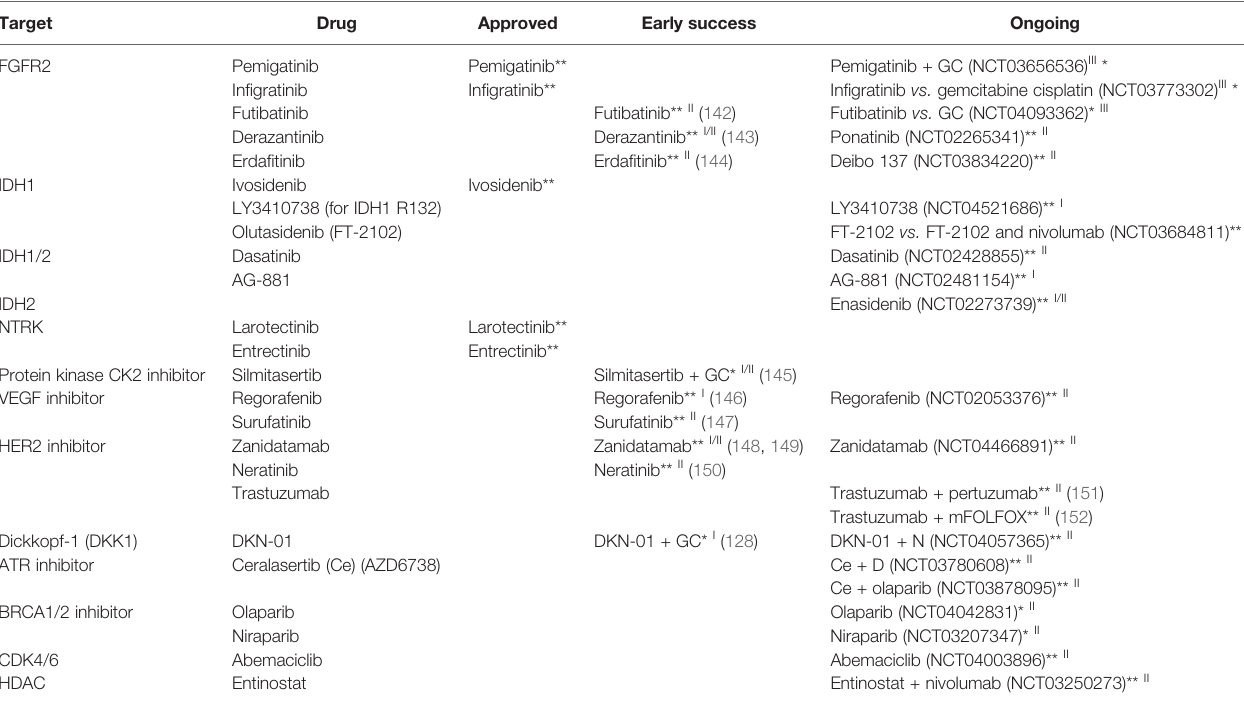
TABLE 4 | Targeted therapy in biliary tract